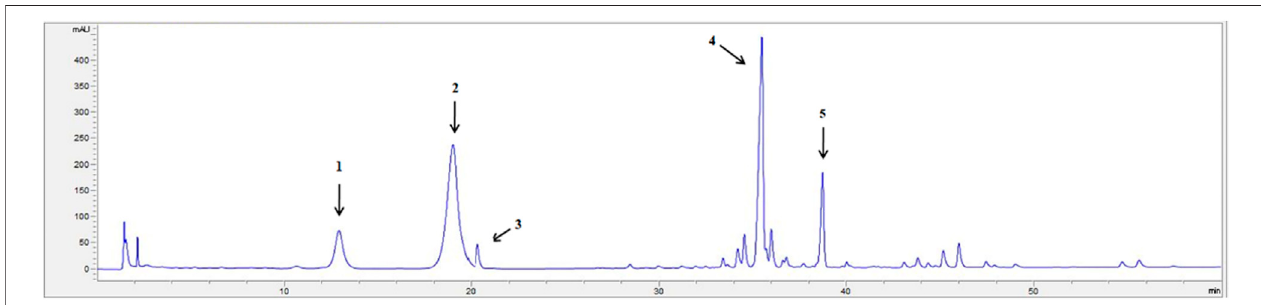
FIGURE 1 | The HPLC fi ngerprint pro fi le of PNS. 1: notoginsenoside R 1 ; 2: ginsenoside Rg 1 ; 3: ginsenoside Re; 4: ginsenoside Rb 1 ; 5: ginsenoside Rd. The chromatography was performed on an Agilent SB-C18 column (250 × 4.6 mm, 5 μ m), at 30 ° C, with a UV detection rate of λ (cid:2) 203 nm and fl ow rate (cid:2) 1.5 ml/min. Gradient elution: acetonitrile (A) and Water (B): 0 min 20% A, 20 min 20% A, 45 min 46% A, 55 min 55% A, 60 min 55% A. The HPLC chromatogram of PNS was authenticated according to the Pharmacopoeia of the People ’ s Republic of China identi fi cation key (2015, Volume 1).